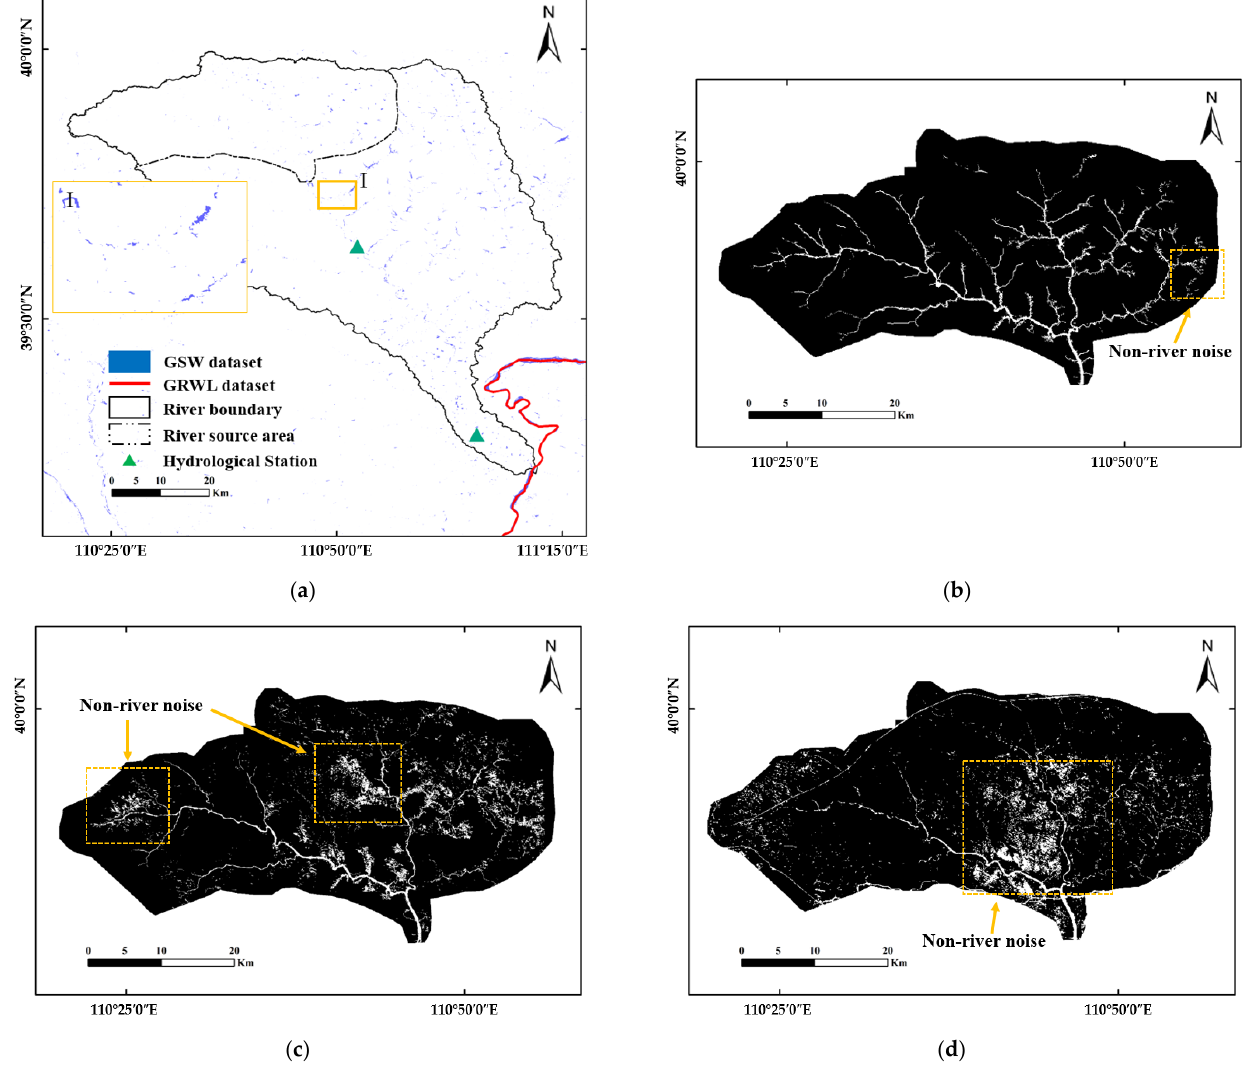
Figure 10. Comparison with different river surface datasets and extraction methods. ( a ) Waterbodies extraction results of existing products in the Huangfuchuan River Basin. Part I shows the unconnected rivers. ( b ) River surface extraction result of RF-ANN in the river source area. ( c ) River surface extraction result of the object-oriented method based on multiscale segmentation in the source area. ( d ) River surface extraction result of OTSU in the source area.